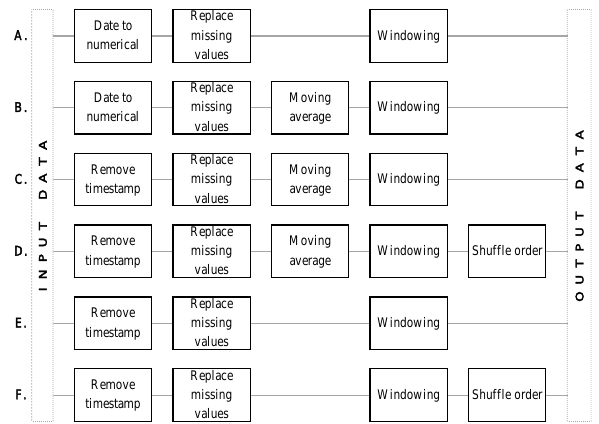
Figure 6. A comparison of all pre-processing scheme